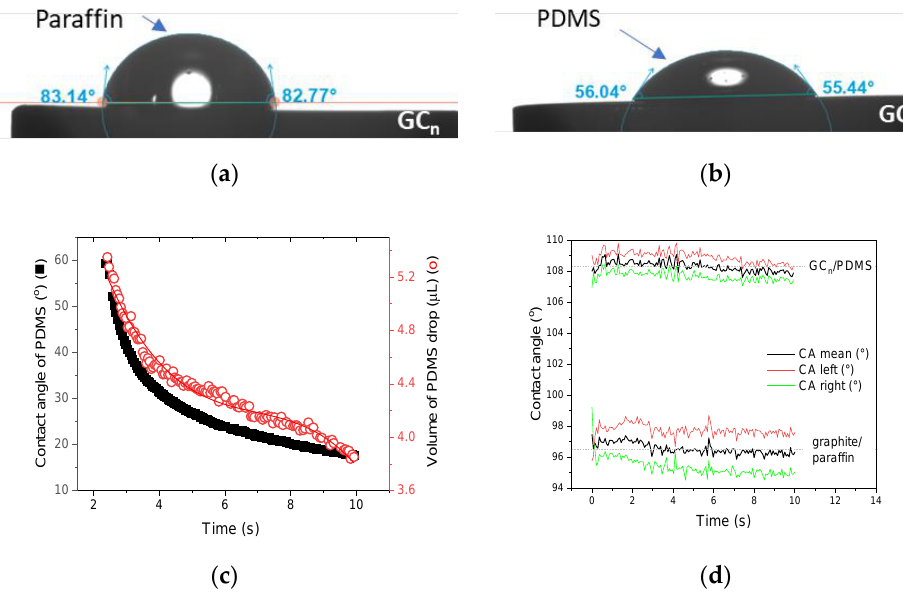
Figure 2. Photographs illustrating the contact angle for ( a ) paraffin drop and ( b ) PDMS drop deposited onto a GC s disc. ( c ) Change in an average contact angle of the PDMS droplet deposited onto the GC n surface and the volume of the PDMS droplet over time. ( d ) Changes in left, right, and mean contact angles of water droplets deposited onto graphite/paraffin and GC n /PDMS